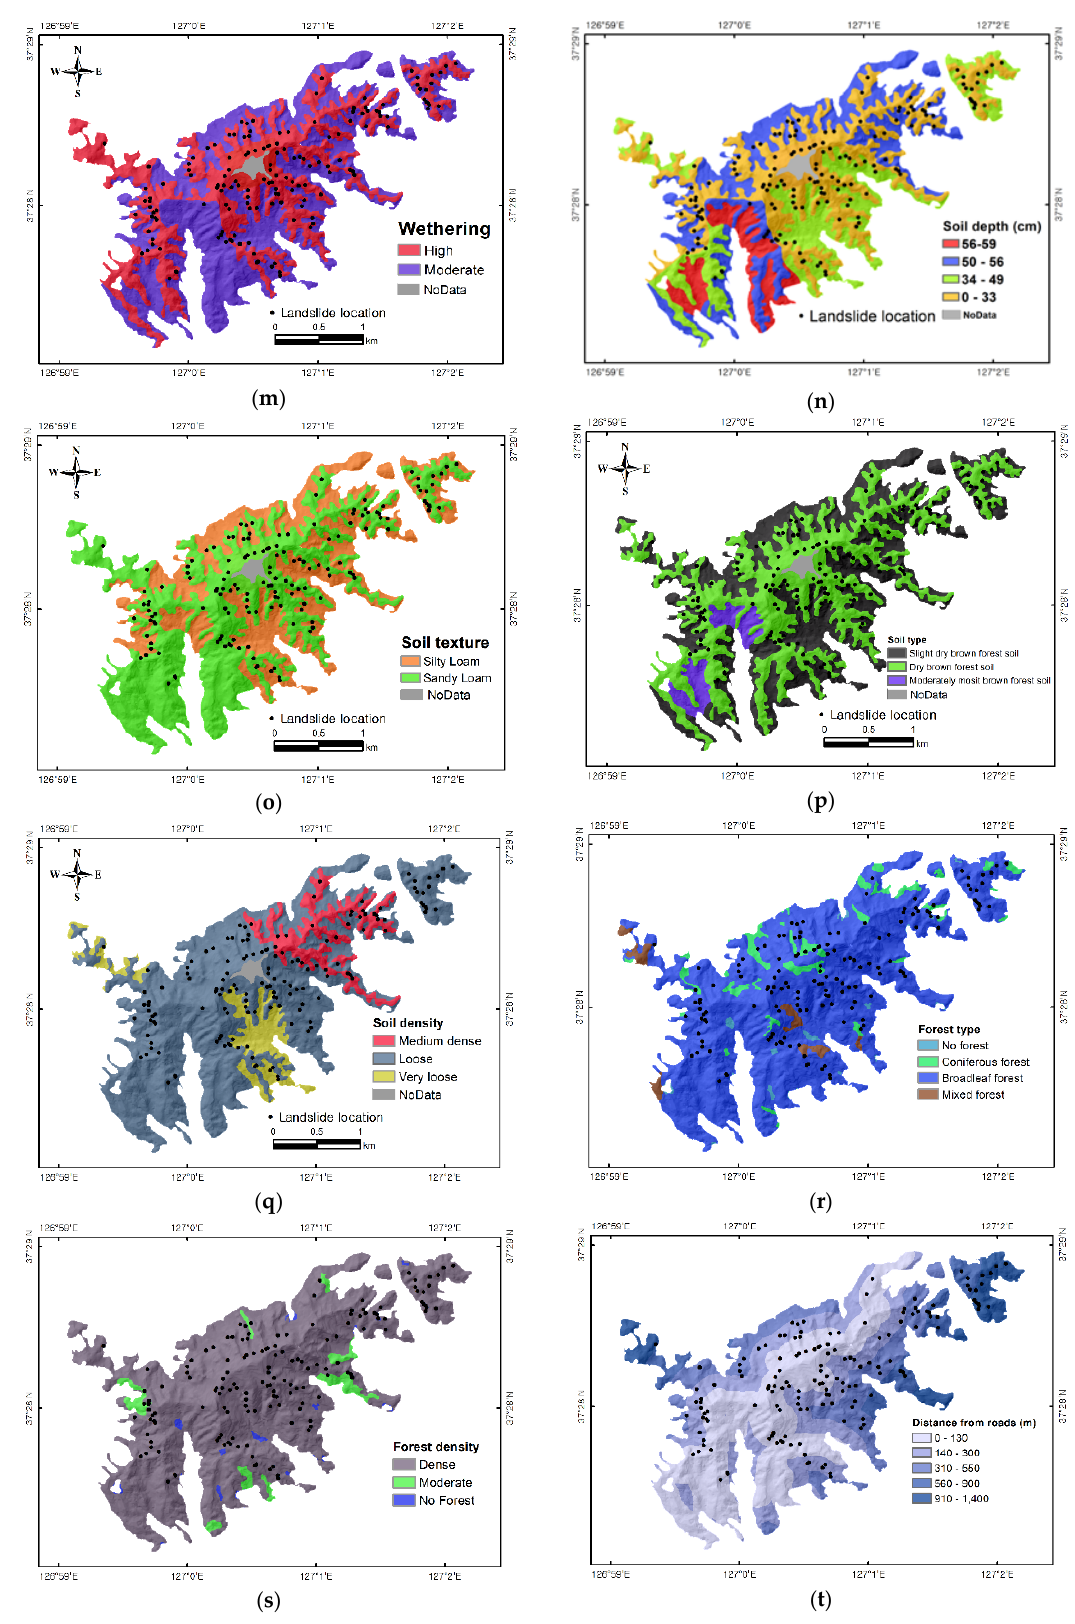
Figure 4. Landslide predisposing factors: ( a ) elevation; ( b ) slope; ( c ) aspect; ( d ) curvature; ( e ) topographic ruggedness index (TRI); ( f ) surface relief ratio (SRR); ( g ) site exposure index (SEI); ( h ) topographic wetness index (TWI); ( i ) sediment transport index (STI); ( j ) stream power index (SPI); ( k ) distance from stream; ( l ) lithology; ( m ) weathering; ( n ) e ff ective soil depth; ( o ) soil texture; ( p ) soil type; ( q ) soil density; ( r ) forest type; ( s ) forest density; ( t ) distance from